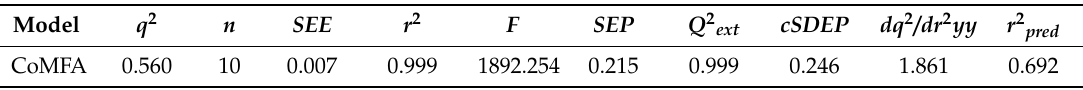
Table 2. Evaluation parameters of the comparative molecular field analysis (CoMFA) models. Model q